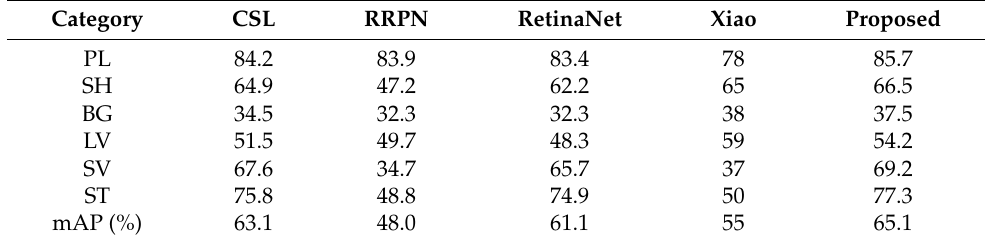
Table 4. Comparison results of different algorithms on the DOTA